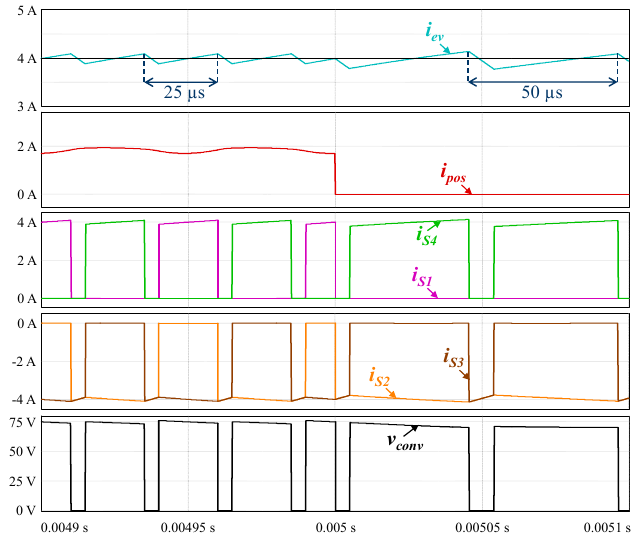
Figure 7. Waveforms of the EV current ( i ev ), dc grid current in the positive wire ( i pos ), currents in the IGBTs S 1 , S 2 , S 3 , S 4 ( i S 1 , i S 2 , i S 3 , i S 4 ), and voltage produced by the dc–dc converter ( v conv ) during the transition from normal operation to operation with a failure in the positive wire of the bipolar dc grid.